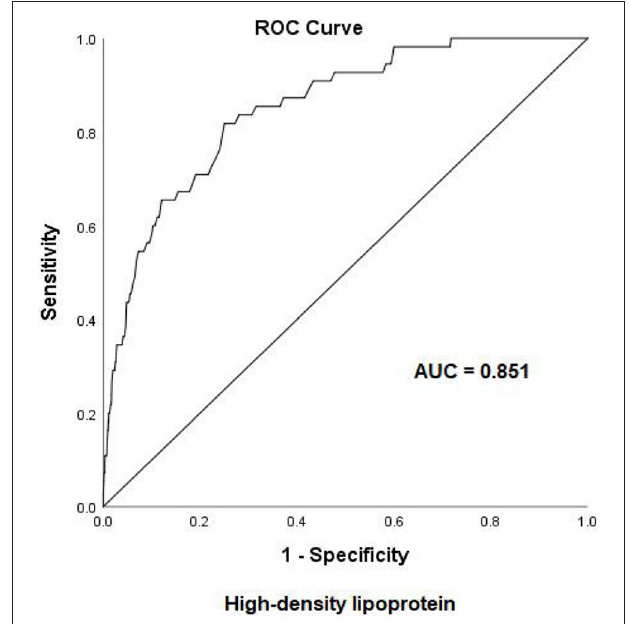
FIGURE 3 | Receiver operating characteristic (ROC) curve analysis for predicting early-onset pre-eclampsia on the basis of maternal high-density lipoprotein (24–28 weeks of gestation). AUC, area under the